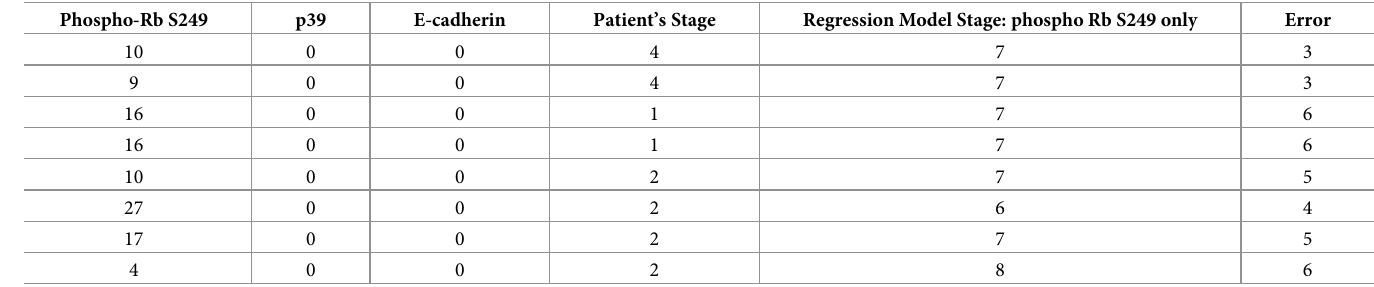
There is a sound rationale behind Rb phosphorylation and p39 expression as potential lung cancer biomarkers. Oncogenic Rb hyper-phosphorylation is common in NSCLC [33], and being a strong driver of oncogenesis, this event may be a constant in a large fraction of tumor cells not subject to tumor heterogeneity. We and other have produced evidence showing that Rb induces cell adhesion [9–16], thus implicating Rb loss in cellular changes germane to Table 5. A random sample of SCC tumors from our TMAs were selected to calculate tumor staging using our linear regression model when considering only phos- phor-Rb S249 score. The tables show the score for phospho-Rb S249, p39, E-cadherin and the patient´s tumor stage ( first fourth columns , respectively ). The fifth column shows the stage predicted by our linear regression analysis only when considering the phospho-Rb S249 score. The Error (sixth) columns in all five tables show the differ- ence between the vendor score and our linear regression analysis score, a value of 0 indicating identical scores, while a number other than 0 means that the two scores were different by a magnitude equal to the number indicated in the column. None of the 7 samples in Rb S249 score alone was able to predict the staging with an error of 0. Based on this analysis, Rb S249 score alone does not have enough precision to predict tumor staging accurately. Phospho-Rb